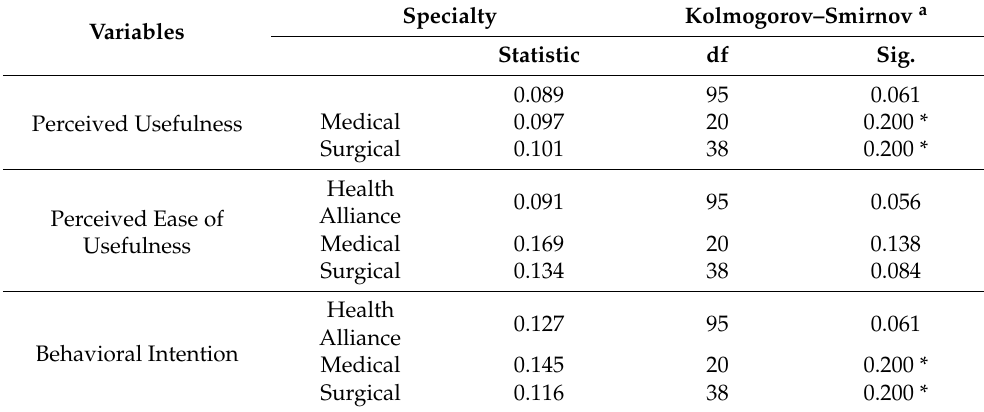
Table 3. Test of normality.